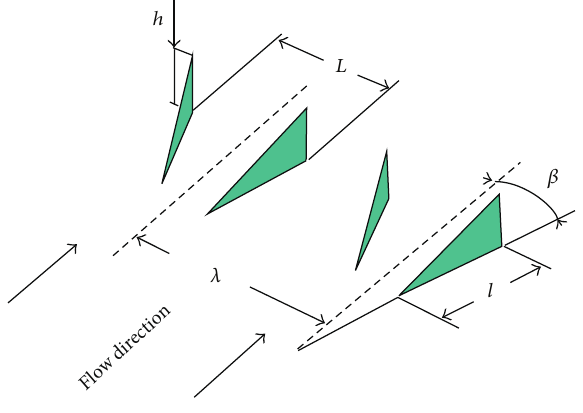
Figure 1: Vortex generator geometry [18].